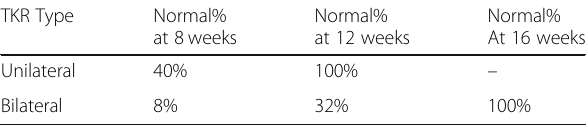
Table 3 % of the patients whose CRP became normal after various